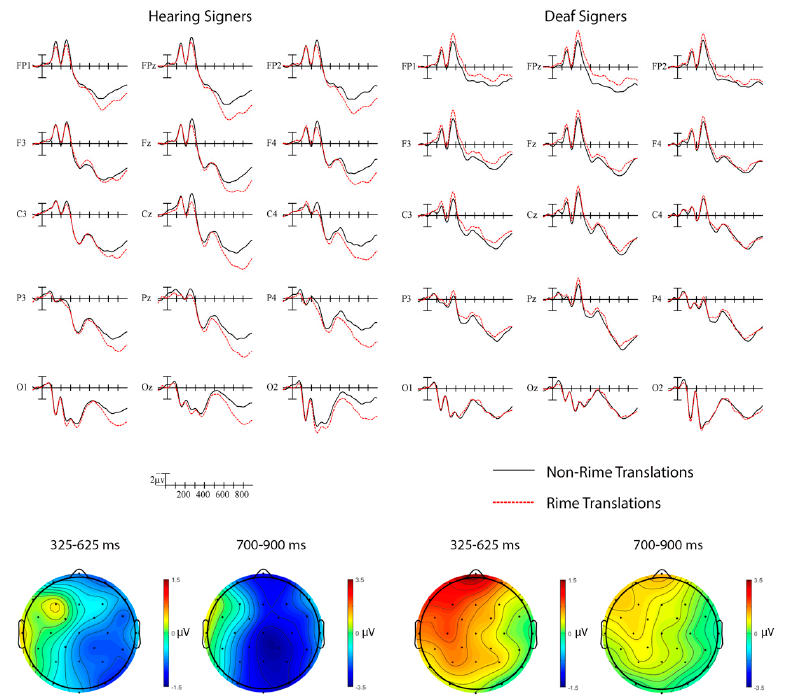
Figure 4. English translation rime priming effects in hearing and deaf signers. Grand average ERP waveforms elicited by targets in non-rime translation (black) and rime translation (red) pairs at 15 sites. Each vertical tick marks 100 ms and negative is plotted up. The calibration bar marks 2 µV. Scalp voltage maps showing the English translation priming effect on mean N400 amplitude (unrelated–related).